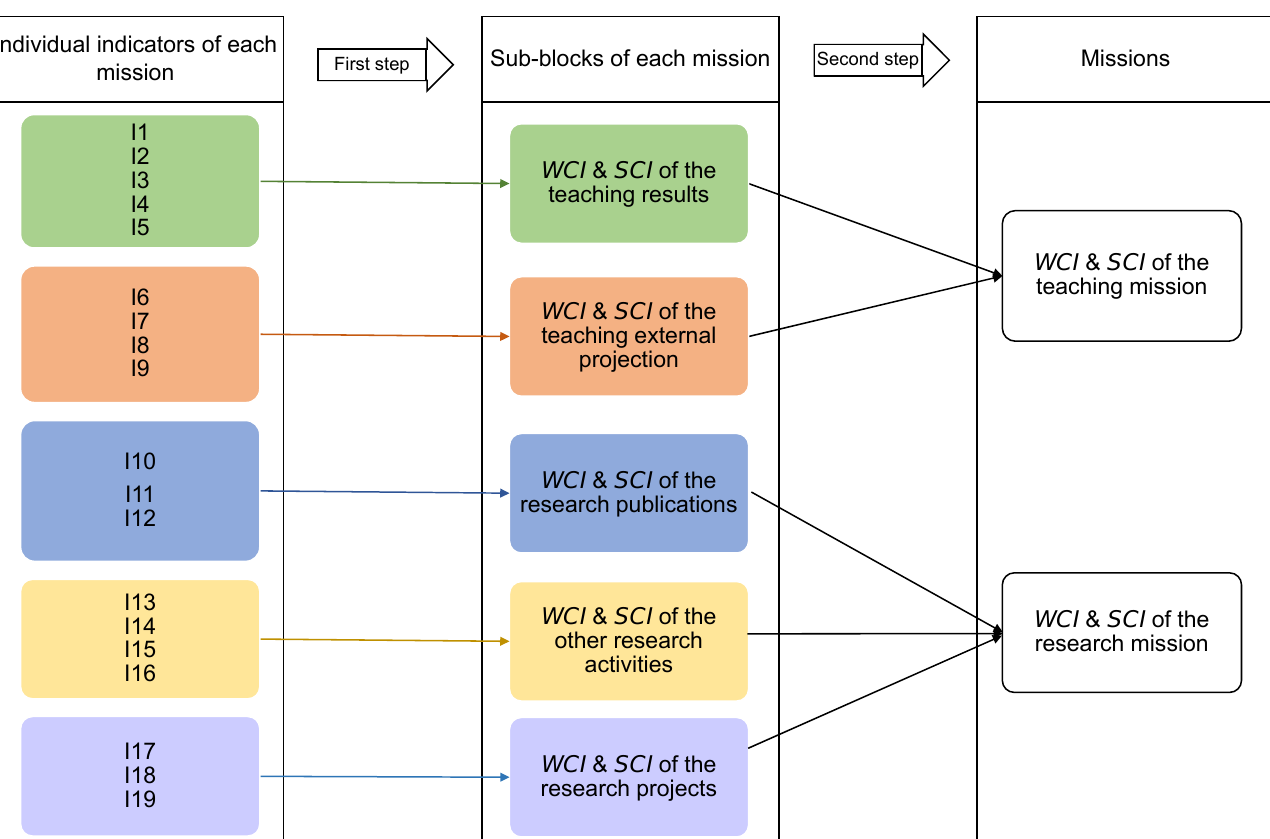
Figure 1. Definition of the three performance levels.